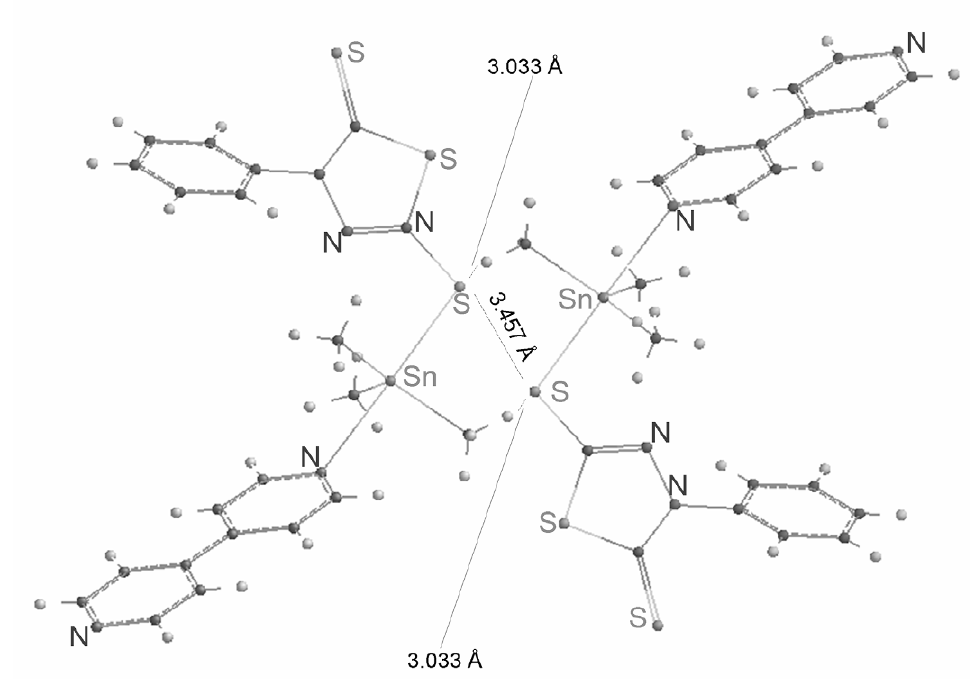
Figure 1. Structure of a compound exhibiting intermolecular S-S interactions between identical sulfur atoms.